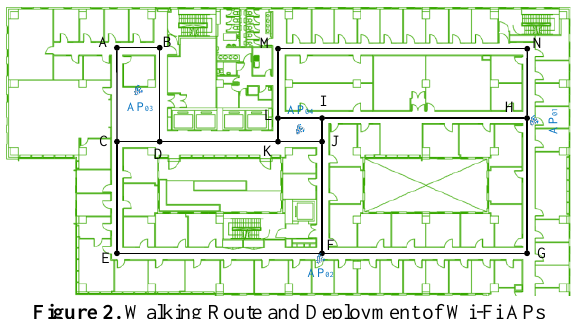
Figure 2. Walking Route and Deployment of Wi-Fi APs